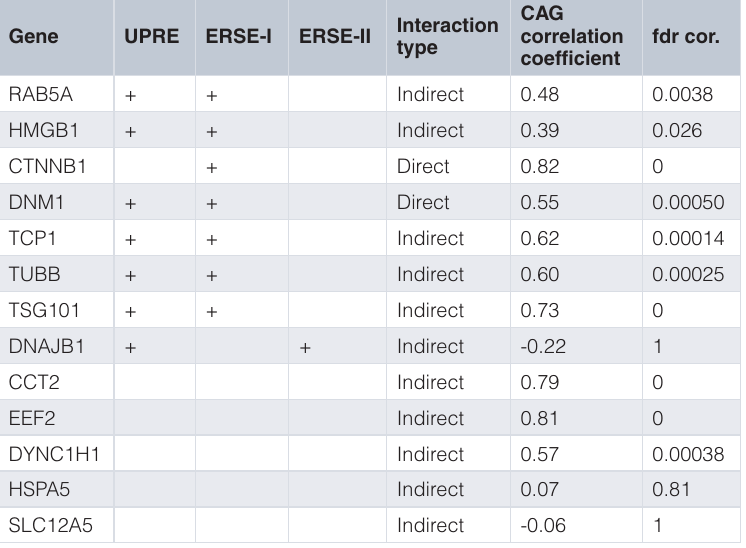
HSP90B1, IKBKB, RPS3A, IKBKG and LMNB1 (Supplementary data file 7). A visualisation of the UPR interactome with apoptosis- related proteins and HTT interactors highlighted can be found in Figure 6. Literature review showed that the two proteins kinases IKBKB and IKBKG, the laminin LMNB1 and the ribosomal protein RPS3A have been previously linked to neurodegenerative diseases. IKBKB and IKBKG are subunits of IkB kinase (IKK). They activate mem- bers of the NF- κ B transcription factor family by phosphorylation of their inhibitor (IkB) 79 leading to ubiquitination and destruction of IkB, thereby allowing activation of the NF- κ B complex. NF- κ B maintains the balance between cell survival and apoptosis 80 .